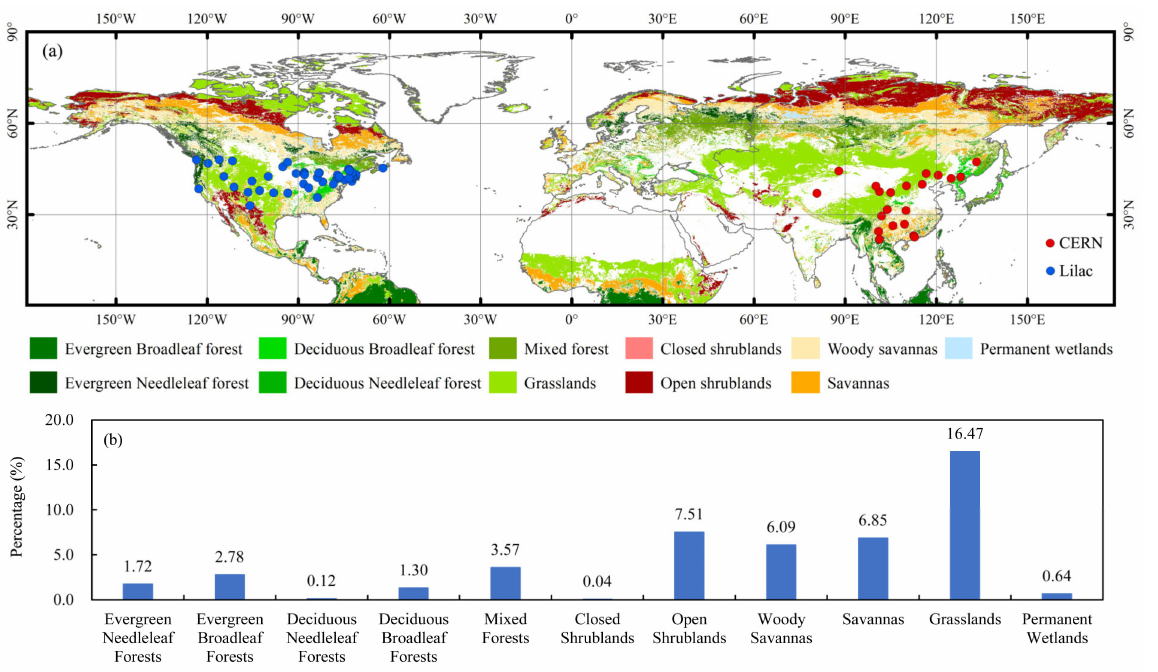
Figure 1. ( a ) The 18-year stable regions with natural-vegetation types from 2001 to 2018 and the dis- tribution of the CERN- and Lilac-phenology observations. ( b ) Percentages of each natural-vegetation type over the